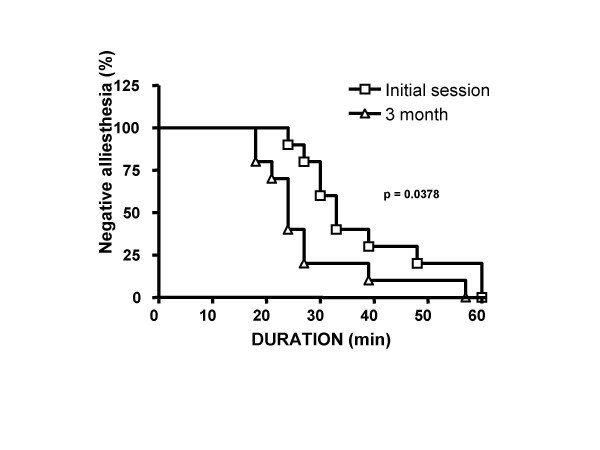
Kaplan-Meier curve was created to determine the time to achieve an event: satiety. Diet showed a significant increase in the satiety rate at 3 mo vs. Initial session (Log-rank chi-square = 4.312, df = 1, p = 0.0378). The median time to achieve satiety was lower after diet (24 min vs. 33 min).